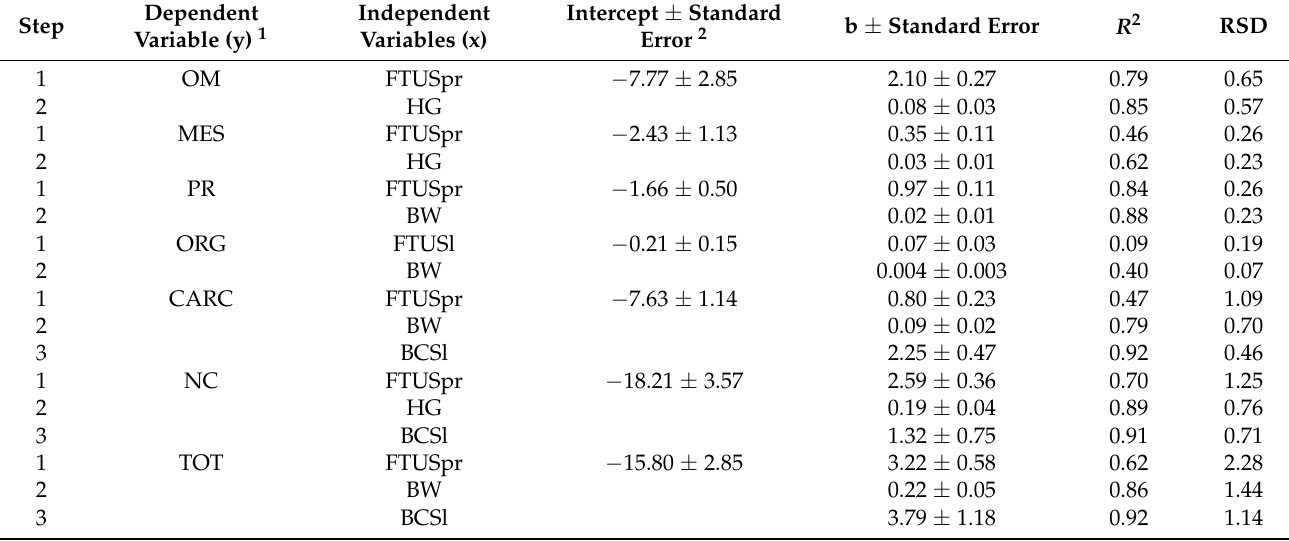
Table 5. Multiple regression equations and coefficient of determination ( R 2 ) and residual standard deviation (RSD) values for estimates of the different fat depot weights (kg) and the total weight of all the fat depots combined (y variables) based on the pre-slaughter measurement values body weight (BW); lumbar and sternal body condition scores (BCSl and BCSs, respectively); heart girth (HG); and lumbar, sternal, and perirenal fat thickness depths measured by ultrasound (FTUSl, FTUSs, and FTUSpr, respectively) ( ×